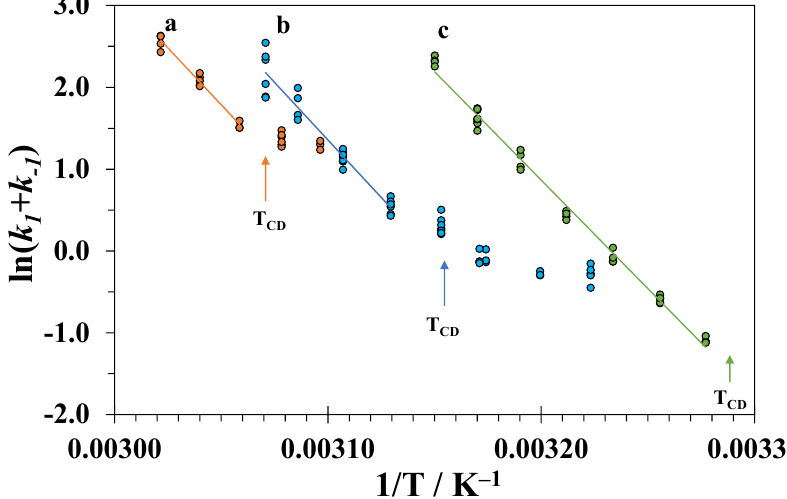
Figure 9. Arrhenius plots for the process of unfolding the tertiary structure of lysozyme in DMSO-water